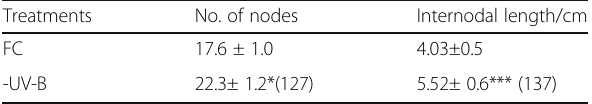
Table 1 Effect of exclusion of UV-B on number of nodes and internodal length of cotton seedlings var. Vikram